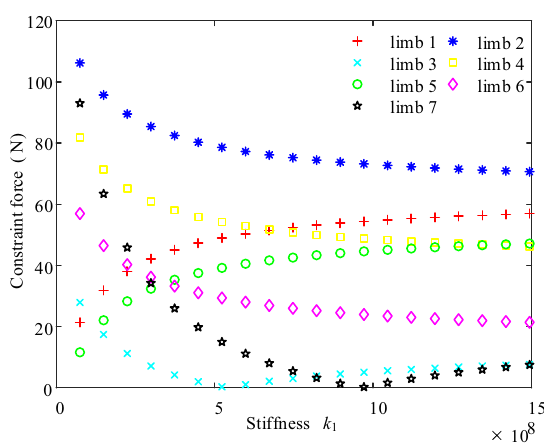
Figure 10 Variation curve of constraint force as the function of k 1